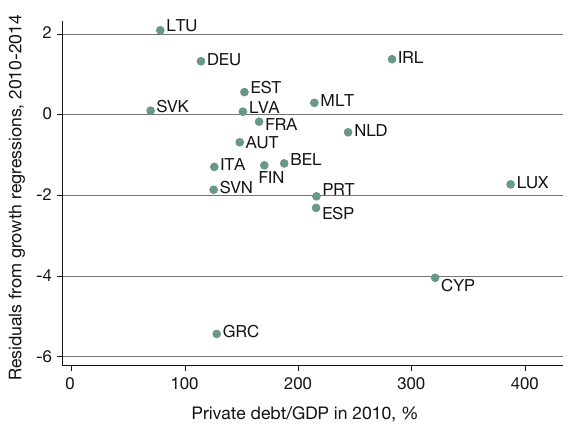
Convergence gaps and private debt stocks